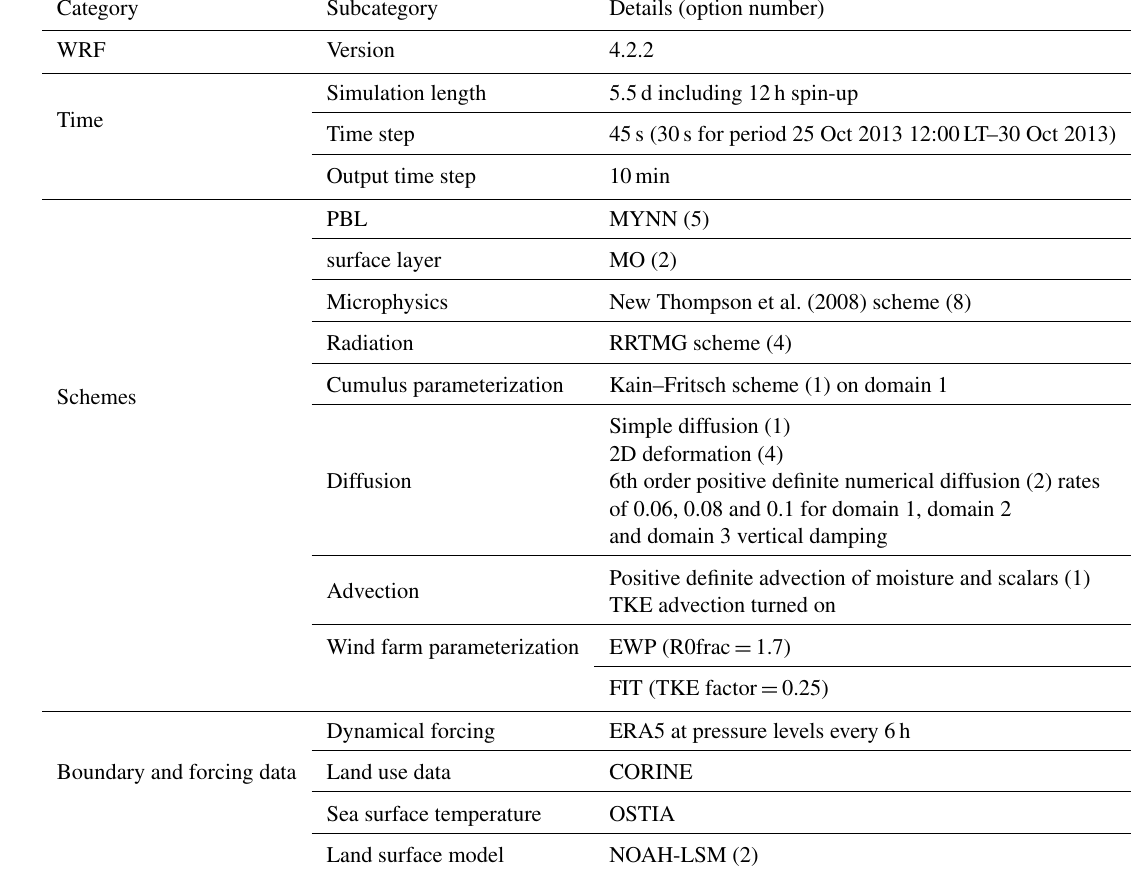
Table 4. WRF parameterization, boundary conditions and forcing data employed for the performed simulations. The wind farm parameteri- zations EWP and FIT were only applied for some scenarios (see Table